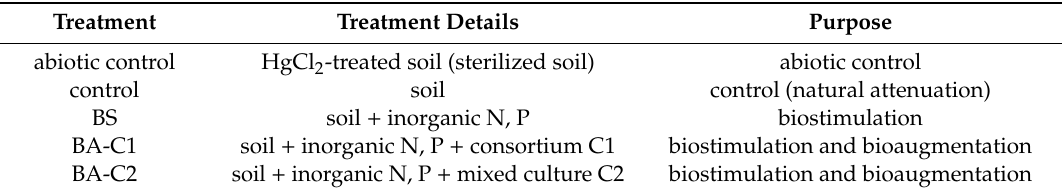
Table 7. Summary of the experimental